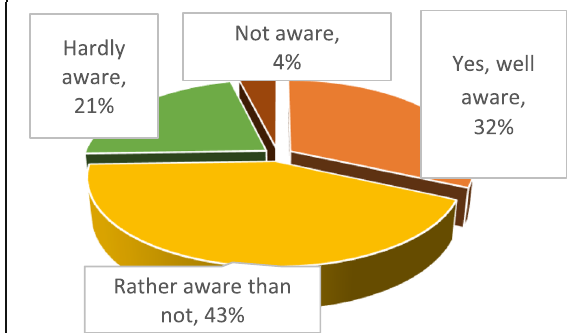
Fig. 1 Awareness by Ukrainian pharmacy students of limited access to effective treatment for more than 2 million